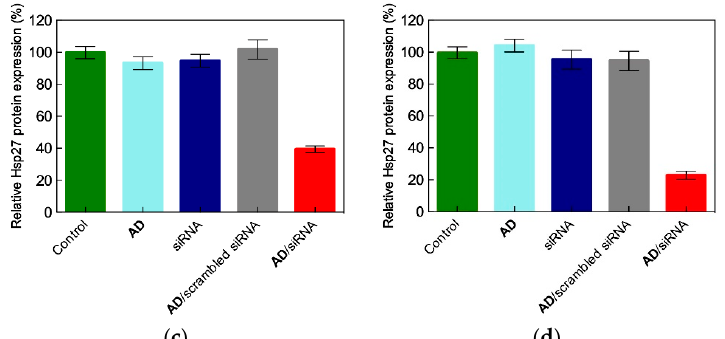
Figure 10. Downregulation of Hsp27 at the mRNA ( a ) and protein (b) level in prostate cancer PC-3 cells treated with siRNA (50 nM) delivered by the self-assembled double-tail dendron AD (N/P = 5). Inhibition of Hsp27 expression by siRNA/ AD complexes (50 nM siRNA, N/P = 5) in breast cancer MCF-7 ( c ) and MDA-MB231 ( d ). Adapted from [6] with permission of John Wiley and Sons, 2014.